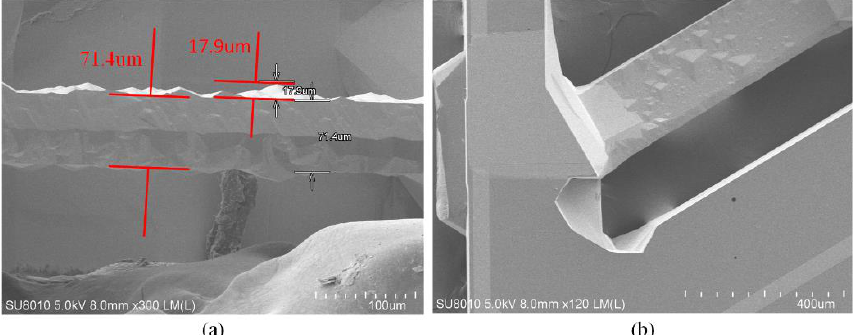
Figure 17. ( a ) The profile of the etched sidewall and bottom with wet chemical etching technology; ( b ) the smoothness of etched bottom wet chemical etching technology.